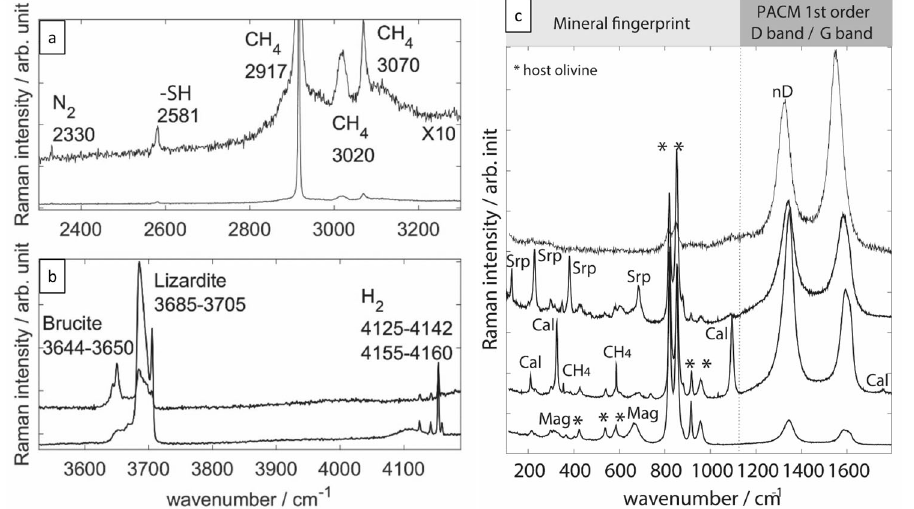
Fig. 2 | Representative punctual Raman analyses of individual fl uid inclusions. disorder (D) band and the graphite (G) band. Few tens of nm-sized nano-diamonds (nD) are identi fi ed by the characteristic downward shift of the D band at ~1325cm − 1 They show a large diversity of gaseous 109 – 111 ( a , b ) and secondary mineral phases 112,113 and of polyaromatic carbonaceous material (PACM) (b , c ) 33 – 36 . CH 4(g) is well identi- (ranging between 1313-1332cm − 1 ), its broadening (FWHM-D of 54 – 70cm − 1 ) and an fi ed by its triplets at 2917, 3020, 3070cm − 1 whereas H associatedGbandnear1550cm − 141 – 44 .InterpretationofparametervariabilityinnDis 2(g) raman shifts are found between4152 – 4142and4155 – 4160cm − 1 .N 2(g) displaysathinbandat2330cm − 1 while complex and beyond the scope of the present contribution. Srp serpentine, Cal the thiolgroup (-SH)of methanethiolCH 3 SH (g) is observed at 2581cm − 1 .The PACMs calcite, Mag are characterized in their fi rst order region by two broad bands assigned to the